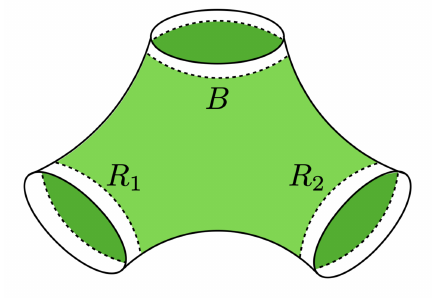
Figure 11 . The three-boundary wormhole corresponding to our current